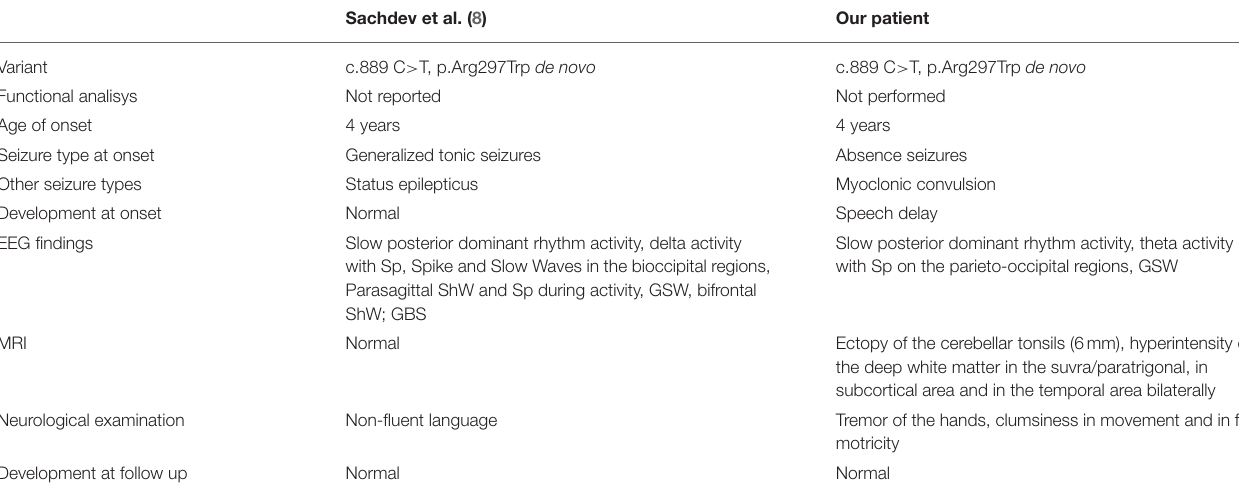
TABLE 2 | Comparison between the characteristics of the patient studied with the only previous case reported in the literature with the same